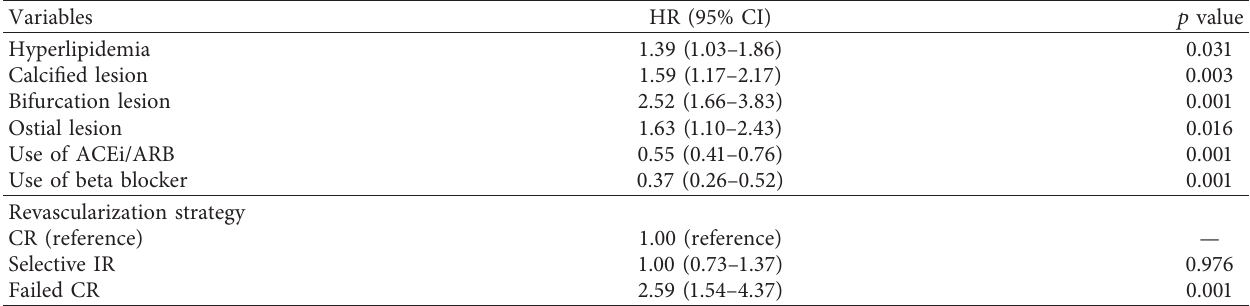
Table 3: Predictors of 5-year MACEs in HF patients with MVD undergoing